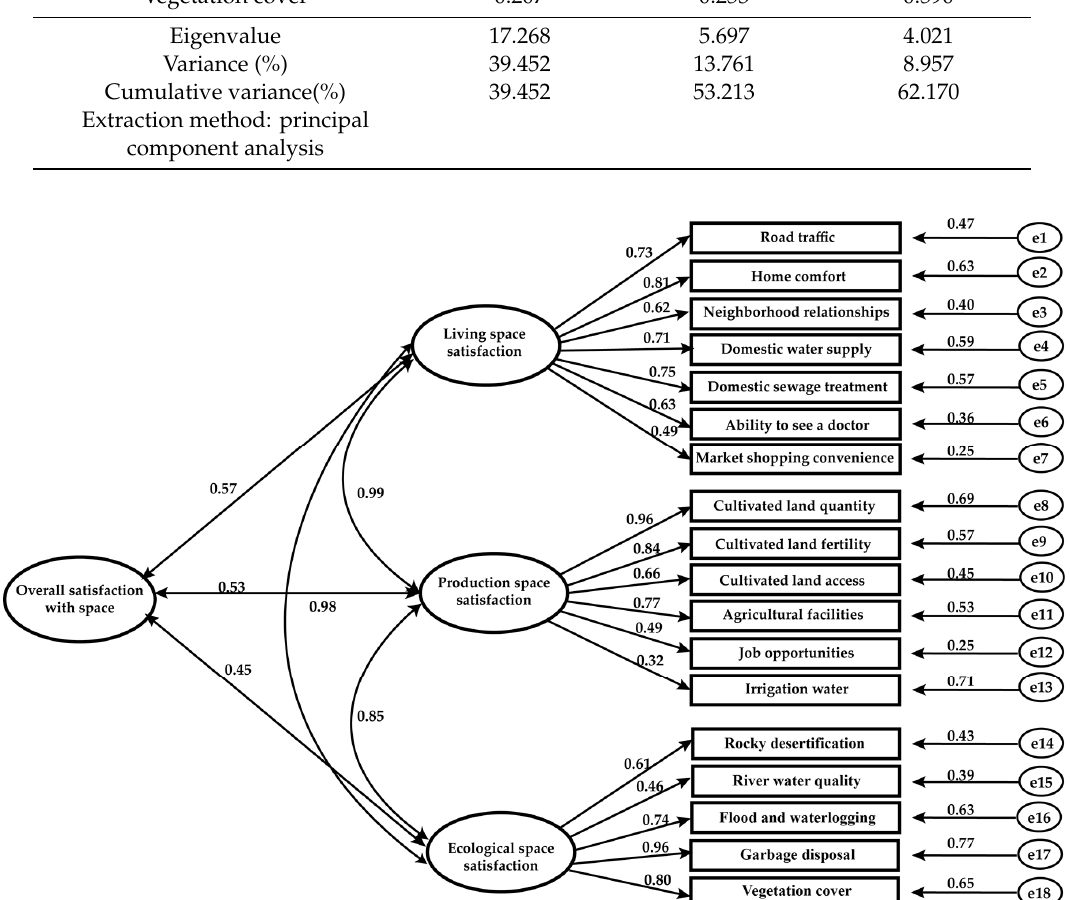
Figure 4. Estimated standardized path parameters of the Ecological–Living–Productive space satisfaction